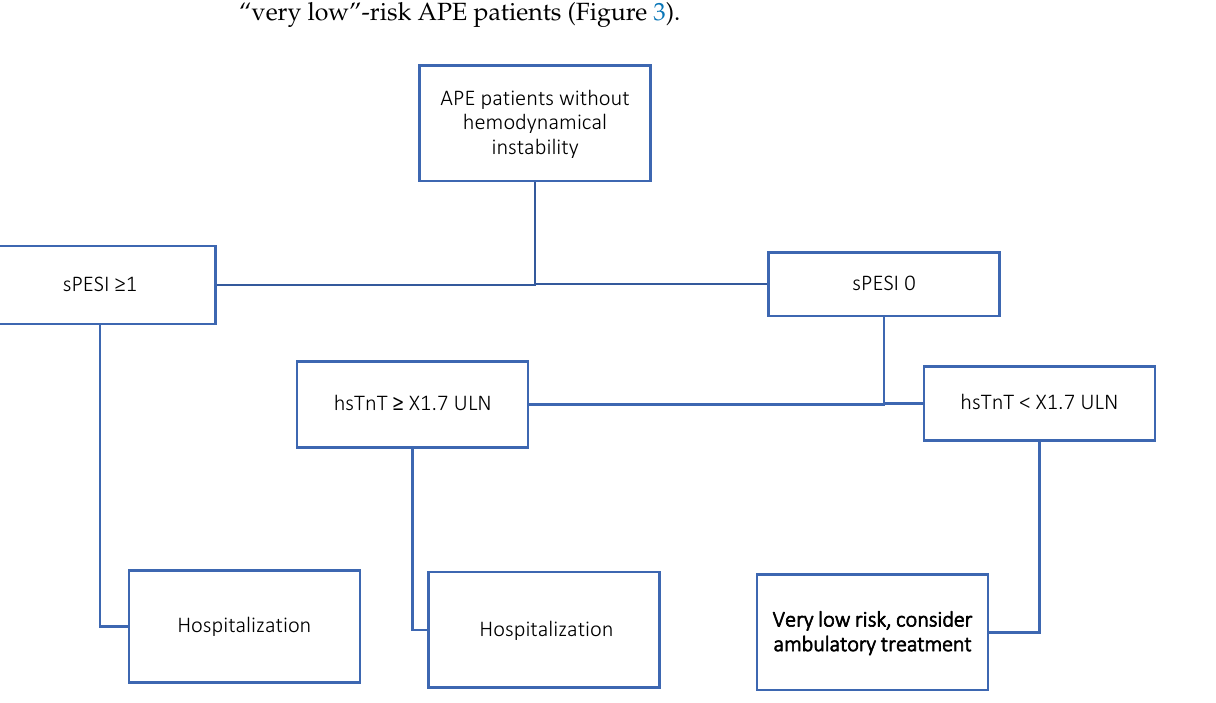
Figure 3. Proposed algorithm for risk stratification in normotensive patients with APE.